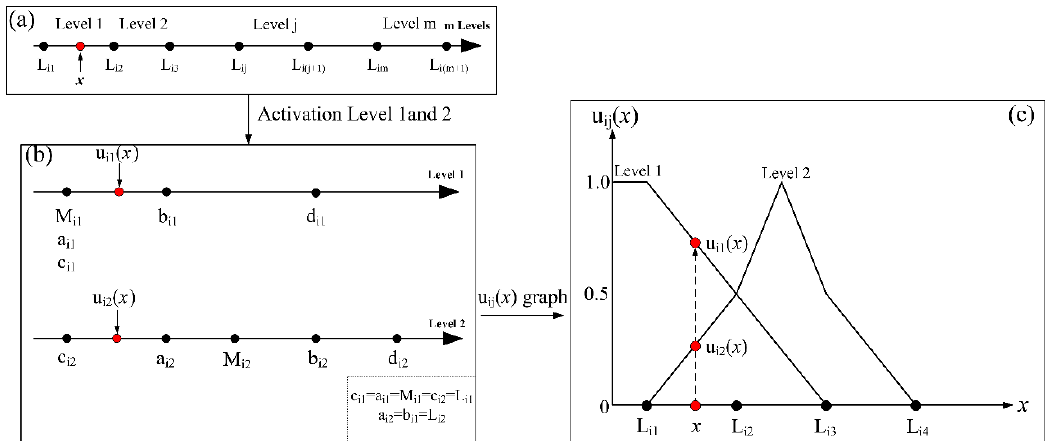
Figure 3. ( a ) The linear relationship between measured value x and standard value L ij ; ( b ) the linear relationship between x and the variable fuzzy set (VFS) model parameters c, a, M, b, and d on activation levels 1 and 2; ( c ) the position of the relative membership degree (RMD) value corresponding to x on the RMD function of activation levels 1 and 2.